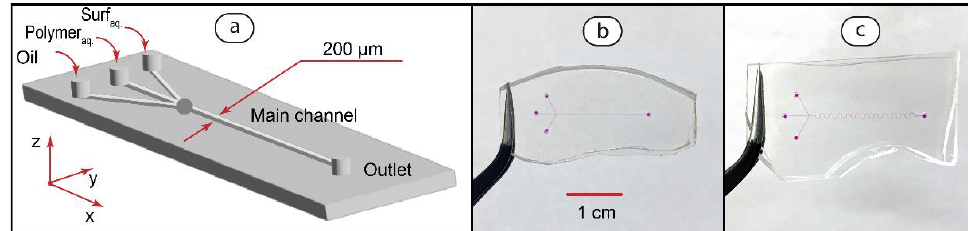
Figure 4. Design of W-type microfluidic chips for performing polyelectrolyte-surfactant reaction in two-phase flows ( a ) and the fabricated devices with the straight ( b ) and serpentine ( c ) main channel geometries. Channels are filled with dye (phenolphthalein in 0.01 M KOH) for visualization.